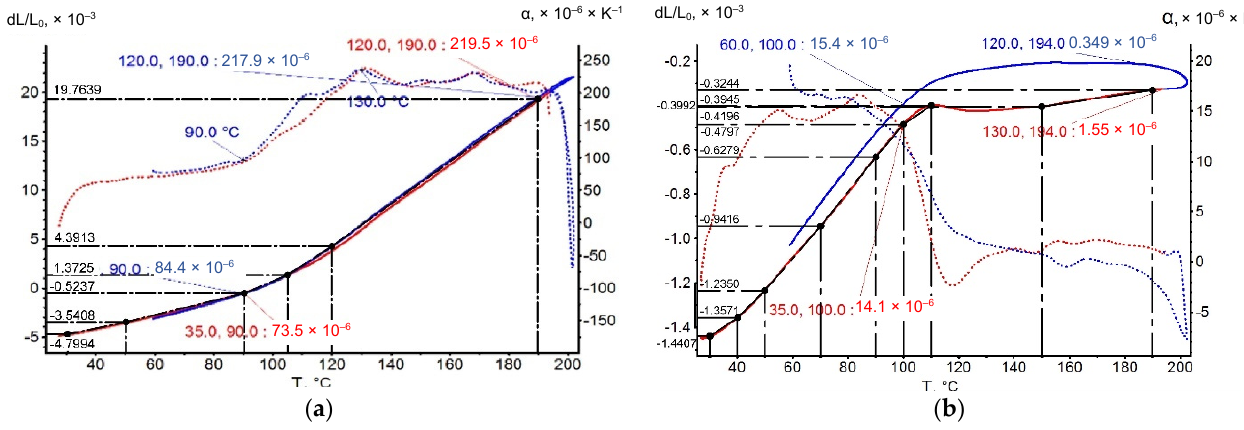
Figure 13. Examples of the graphical determination of the relative strain values for calculating the CTE: ( a ) for EP epoxy binder not subjected to thermal aging; ( b ) for fiberglass EP binder and T-23 fiberglass fabric.